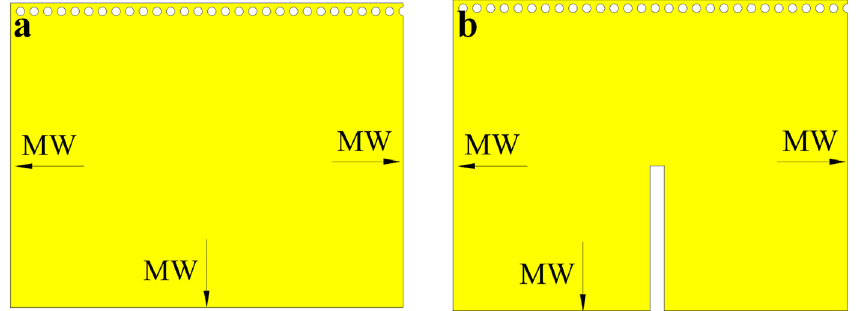
Figure 8. ( a ) Dual-mode HMSIW resonator without slot ( b ) Dual-mode HMSIW resonator with slot. MW— magnetic wall.